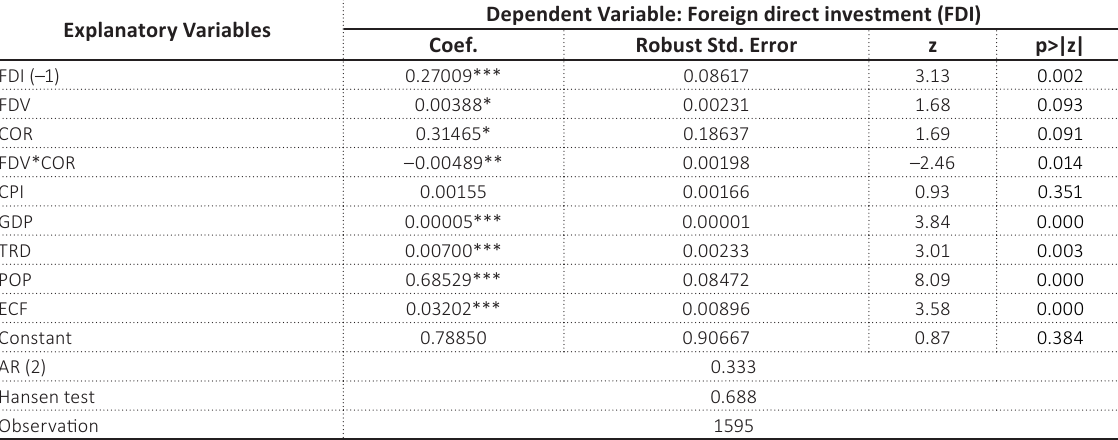
Table 4. The interaction effect between financial development and corruption on foreign direct